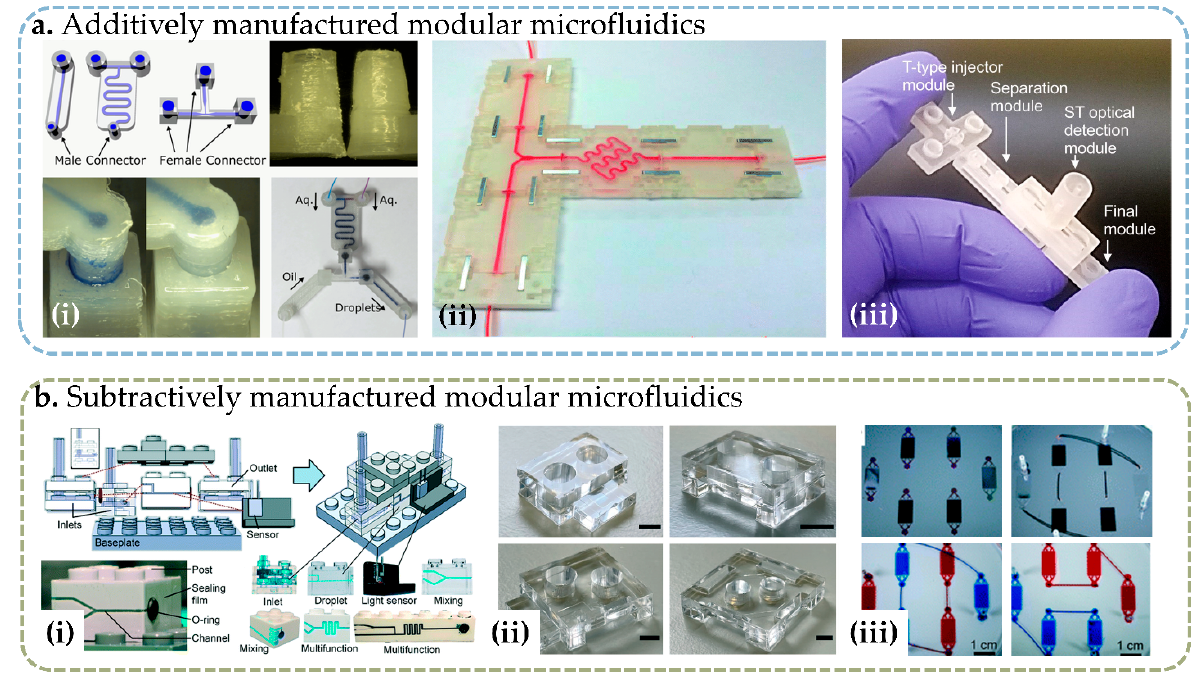
Figure 3. Photographs of modular microfluidic assembly blocks fabricated through different techniques: ( a ) microfluidic blocks created by additive manufacturing, including ( i ) FDM 3D-printed blocks [39], reprinted under Creative Commons CC-BY license, ( ii ) SL 3D-printed microfluidic assembly blocks, reprinted with permissions from Ref. [44]. 2014, Royal Society of Chemistry. ( iii ) PolyJet 3D-printed blocks, reprinted from Ref. [63]. 2019, IOP Publishing; ( b ) microfluidic blocks created by subtractive manufacturing, including ( i ) micro-milled Lego-like modules on injection-molded blocks [26], ( ii ) microfluidic blocks created by laser ablation [68], and ( iii ) microfluidic blocks created using template molding on a lithographic patterned and reactive ion-etched templates [69]. Reprinted with permissions from the Royal Society of Chemistry.